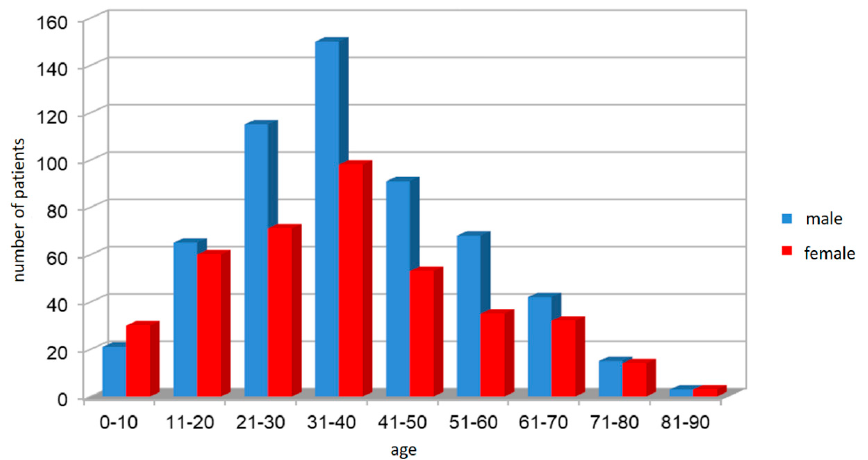
Figure 1. Age and gender distribution of patients.